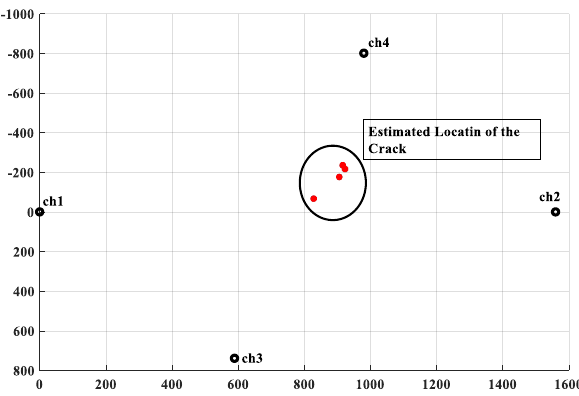
Figure 11. Planer diagram of the estimated location of the crack.